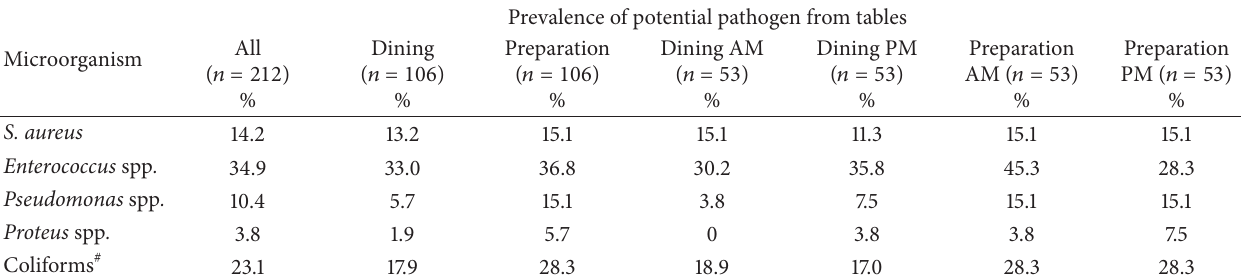
Prevalence of potential pathogen from tables